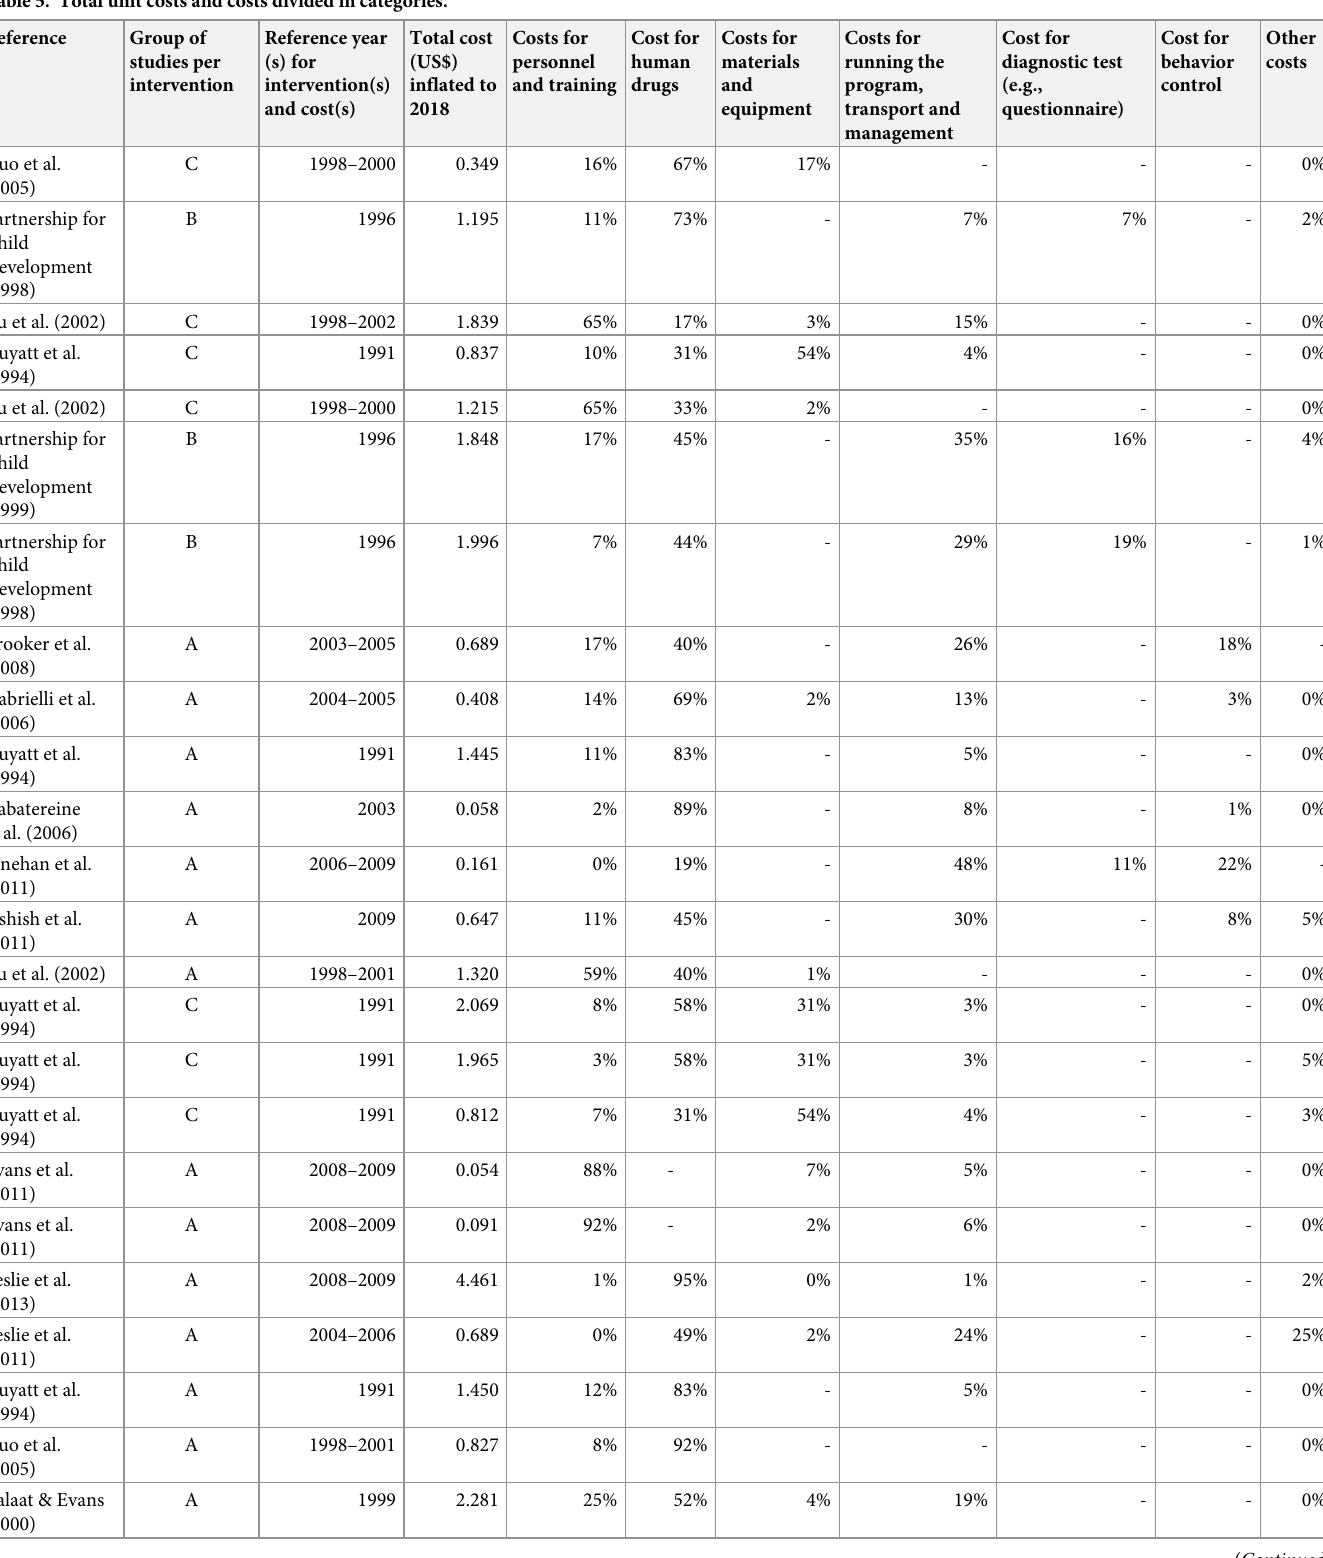
Table 5. Total unit costs and costs divided in